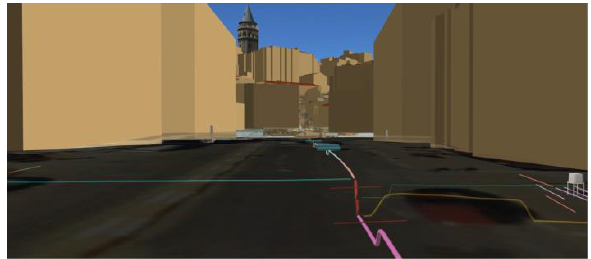
Figure 13. 3D visualization of underground utility (gas).